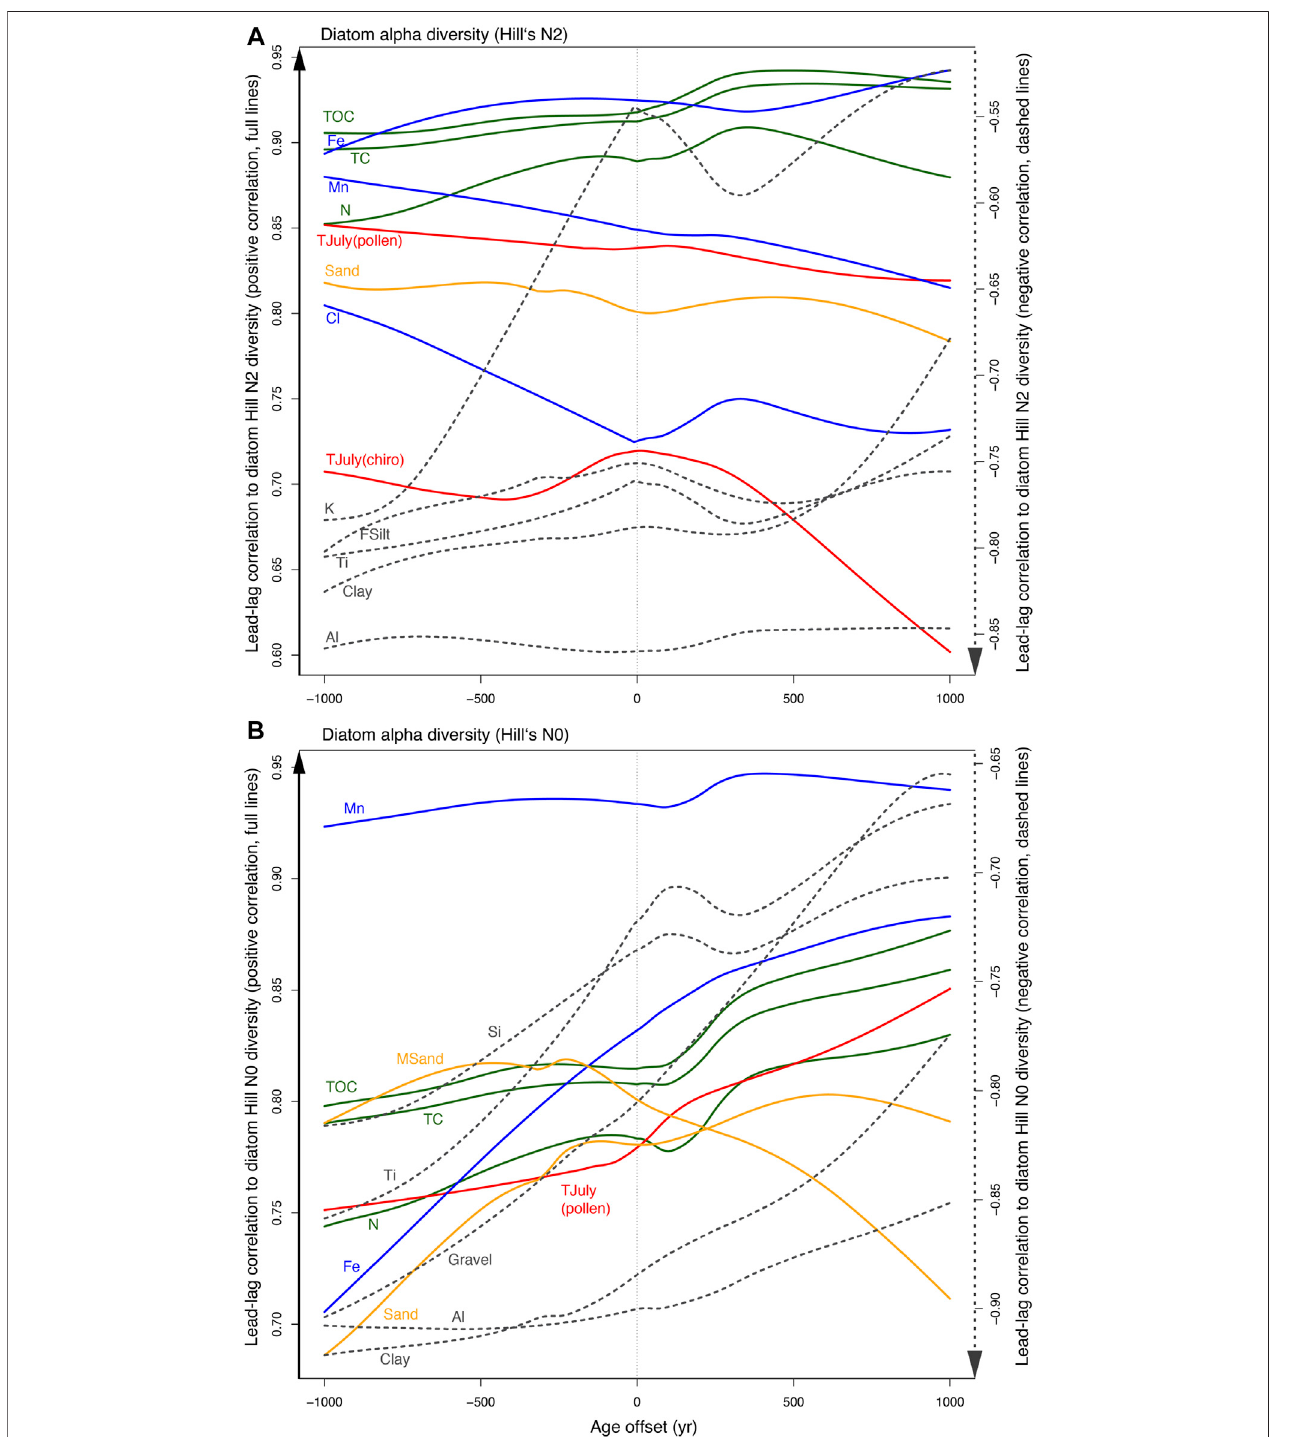
FIGURE10 | Lead-lagcorrelationsof diatom alpha diversity arebased on (A) Hill ’ s N2and (B) Hill ’ sN0, and include all involved proxies correlating > 0.7 (solid lines indicate positive correlation) or < − 0.7 (dashed lines indicate negative correlation). Before analysis the data were LOESS smoothed and re-sampled into an integrated decadal resolution time series. Then, spearman-based correlation was applied in a successive bi-directional 10-year moving temporal offset to maxima of ± 1,000 year. Cross-correlation tests based on auto correlation function are provided in the supplementary material.